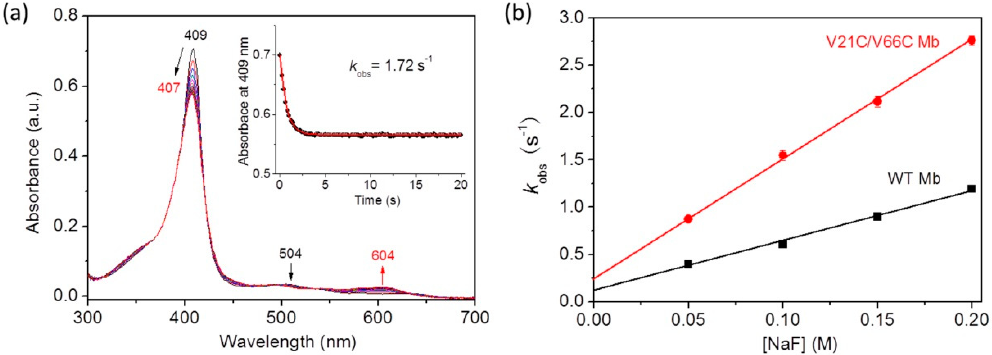
Figure 5. ( a ) Stopped-flow spectra upon mixing V21C / V66C Mb and fluoride (5 µ M and 100 mM, respectively, final concentration) in 100 mM KH 2 PO 4 buffer (pH 7.0) for 20 s. ( b ) Plots of observed rate constants versus fluoride concentrations, with WT Mb shown for comparison. Table 1. Comparison of the kinetic parameters of fluoride binding to WT Mb and the double mutant of V21C/V66C Mb with an intramolecular disulfide bond. Proteins